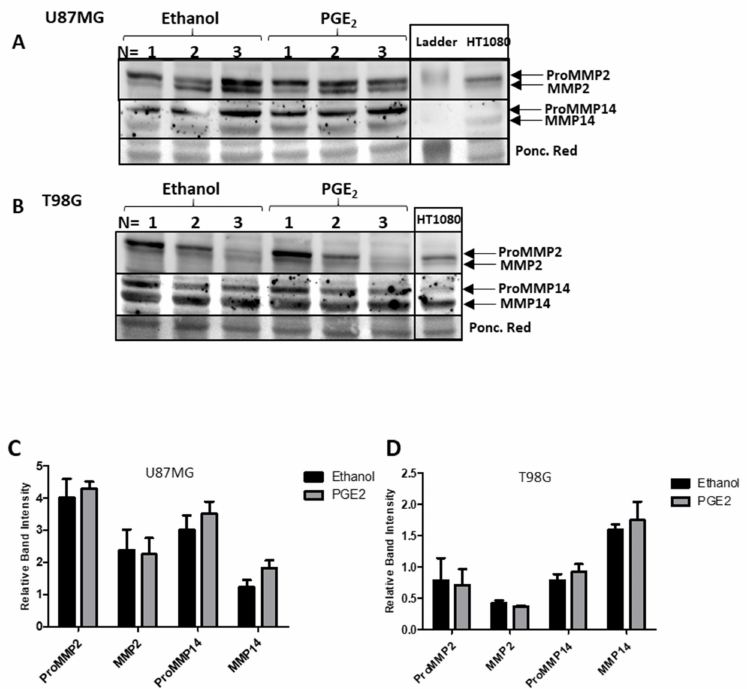
Figure 12. Western Blot and relative band intensities of GBM cells treated with exogenous PGE 2 . Cells were cultivated with PGE 2 (10 µ M) for 24 h and total cell protein was extracted. Each lane represents a separately cultivated trial and contains 40 µ g of protein. ( A , C ) U87MG cells; ( B , D ) T98G cells. ( C , D ) show the relative expression of proMMP2 (72 kDa), MMP2 (MMP-2: 62 kDa), proMMP14 (63 kDa) and MMP14 (60 kDa) normalized to Ponceau Red staining of the same membrane. Data are presented as mean + SEM, n = 3. A two-way ANOVA with a Bonferroni post-test was performed. Differences were considered significant at p < 0.05.